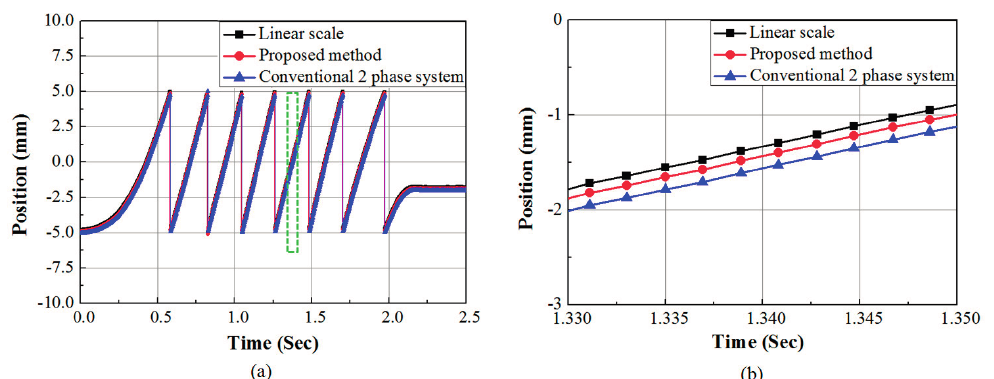
Figure 10. ( a ) Mover position using the proposed method and conventional two phase system; ( b ) Zoom in time and position axes of ( a ) to show the deviation of proposed and conventional two phase system output from reference